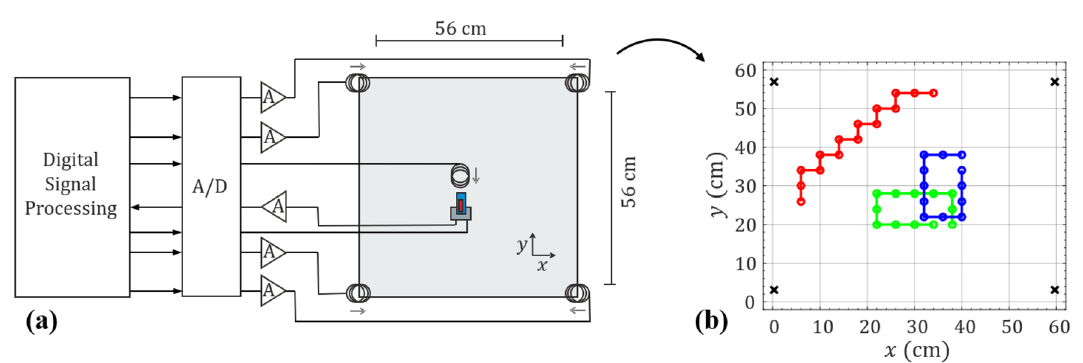
Figure 5. Dual-mode and localization test setup. ( a ) Measurement setup for the dual-mode operation of the exchange bias ME sensors. Four coils are positioned around the measurement area for the localization of the ME sensor and one additional coil is generating a magnetic test signal. The orientations of the coils are denoted by the grey arrows. The source coil is always oriented towards the sensor and shown here for the example of the sensor being oriented along the y-axis. ( b ) Sensor positions used for testing the localization of the ME sensor. Three different sets of positions (green, blue, and red circles) have been tested. The black crosses mark the positions of the transmitting coils. In total, 39 different positions were tested. With two different orientations each this results in a total of 78 different position-orientation